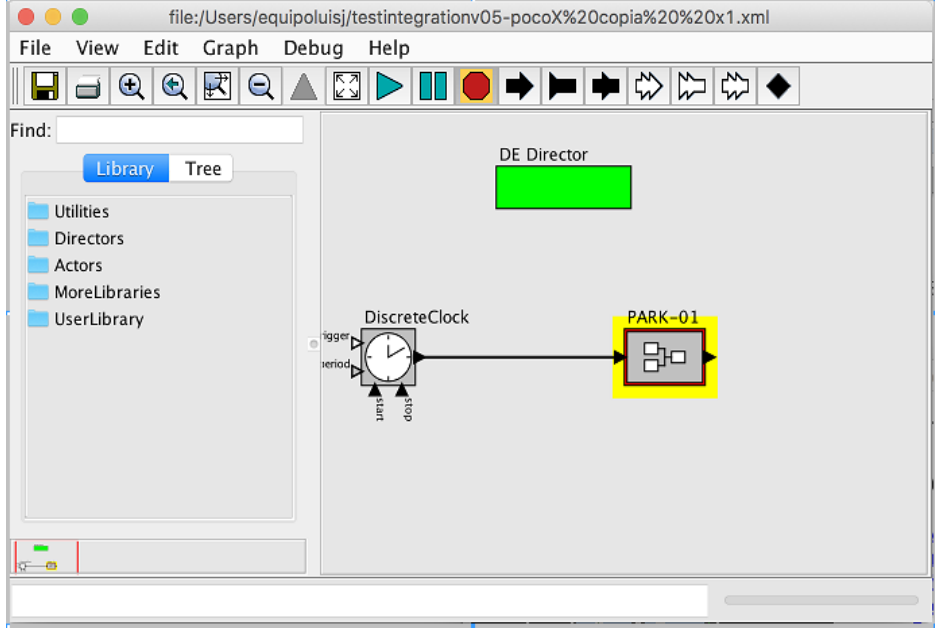
Figure 4. Model of a park in a city.